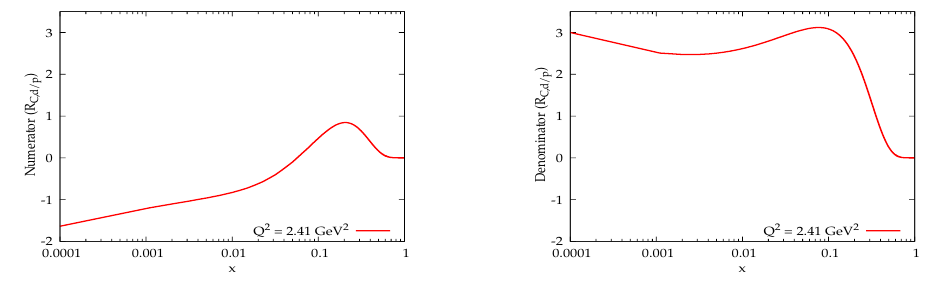
(deutron target) and D , d < 5 GeV. T